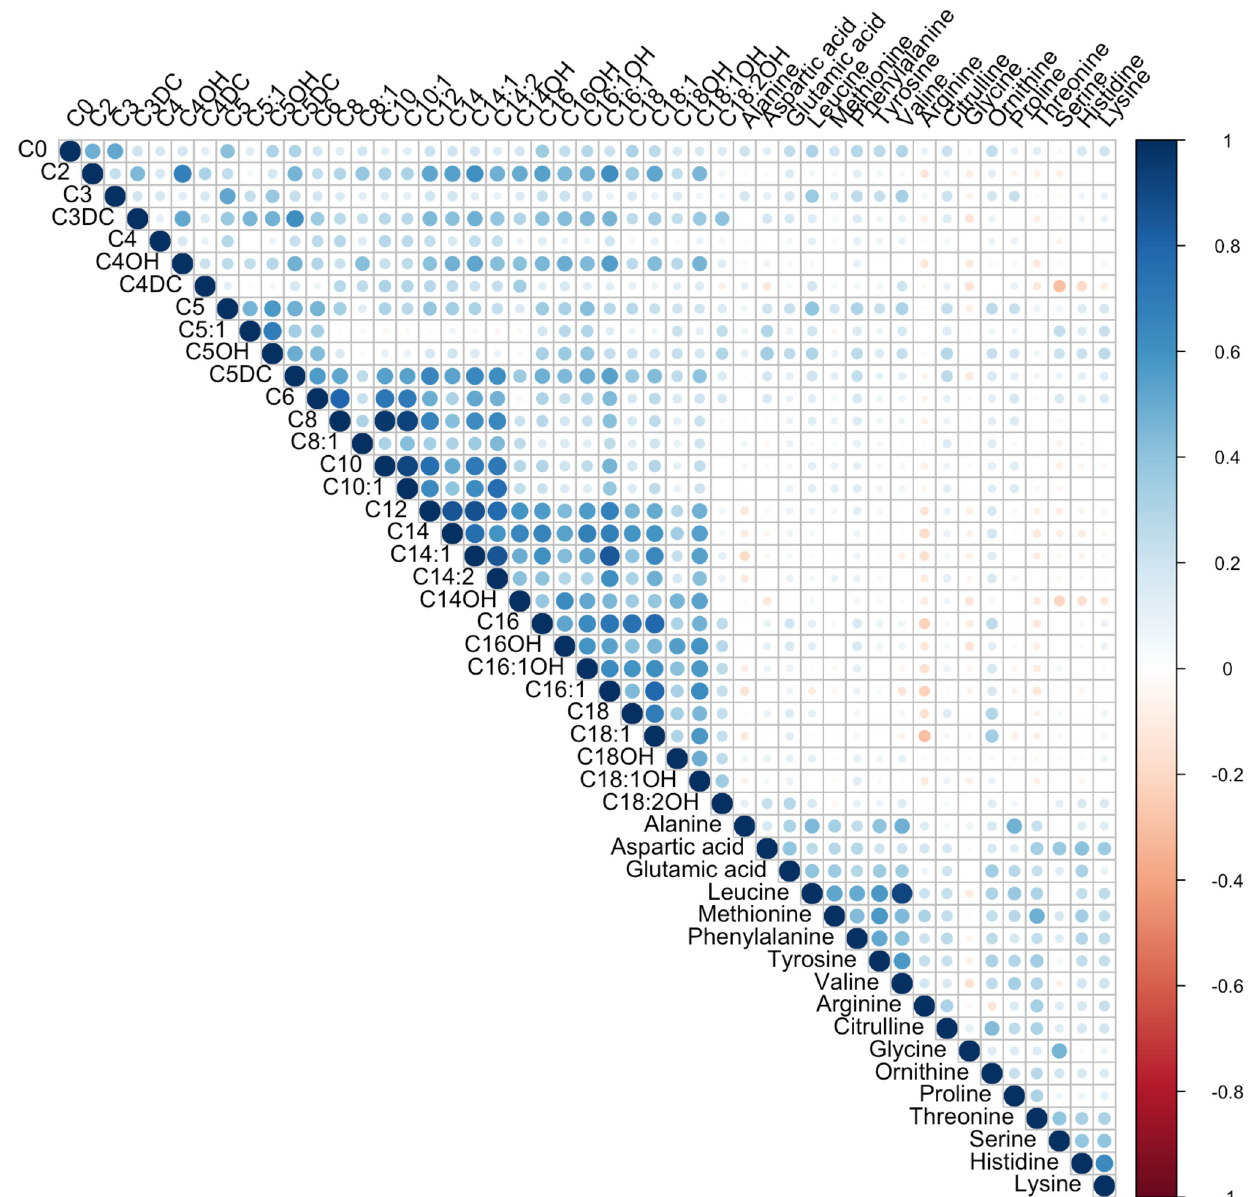
Fig 1. Heatmap correlation between plasma metabolites in total